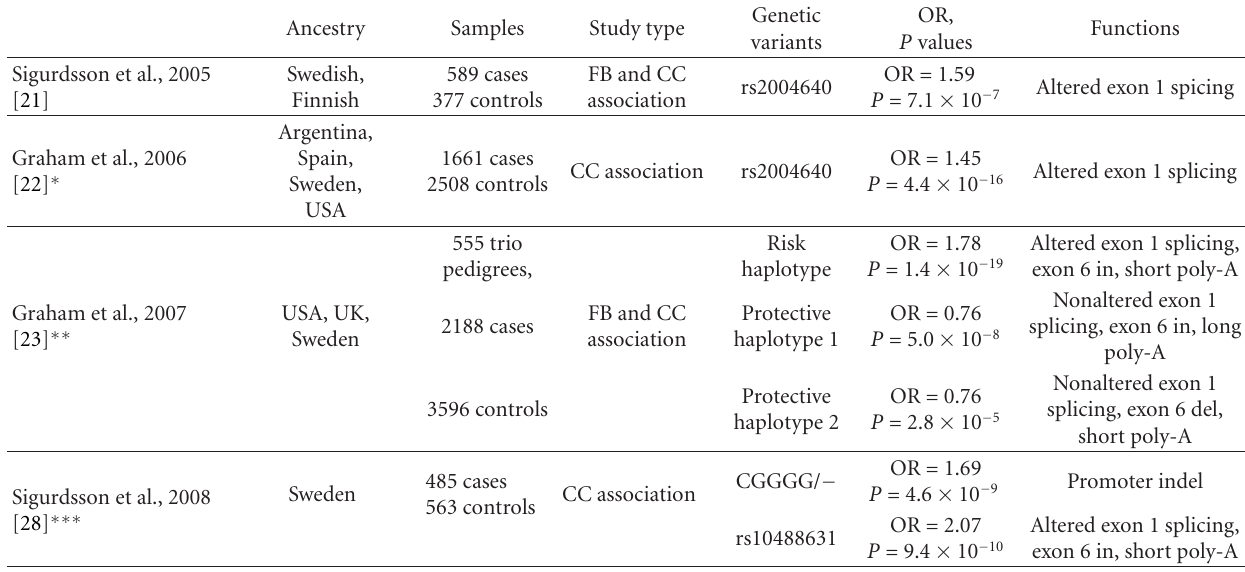
Table 1: Summary of genetic variants found in early seminal